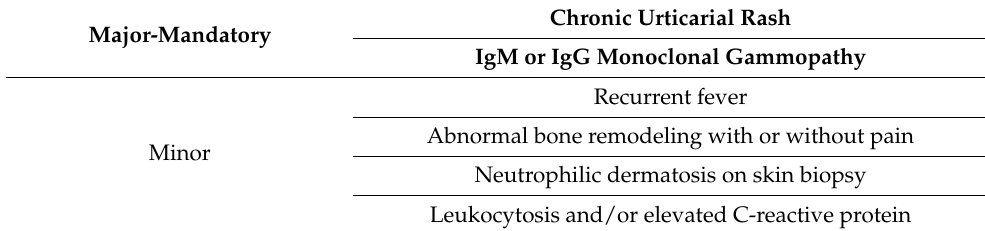
Table 7. Schnitzler syndrome diagnostic